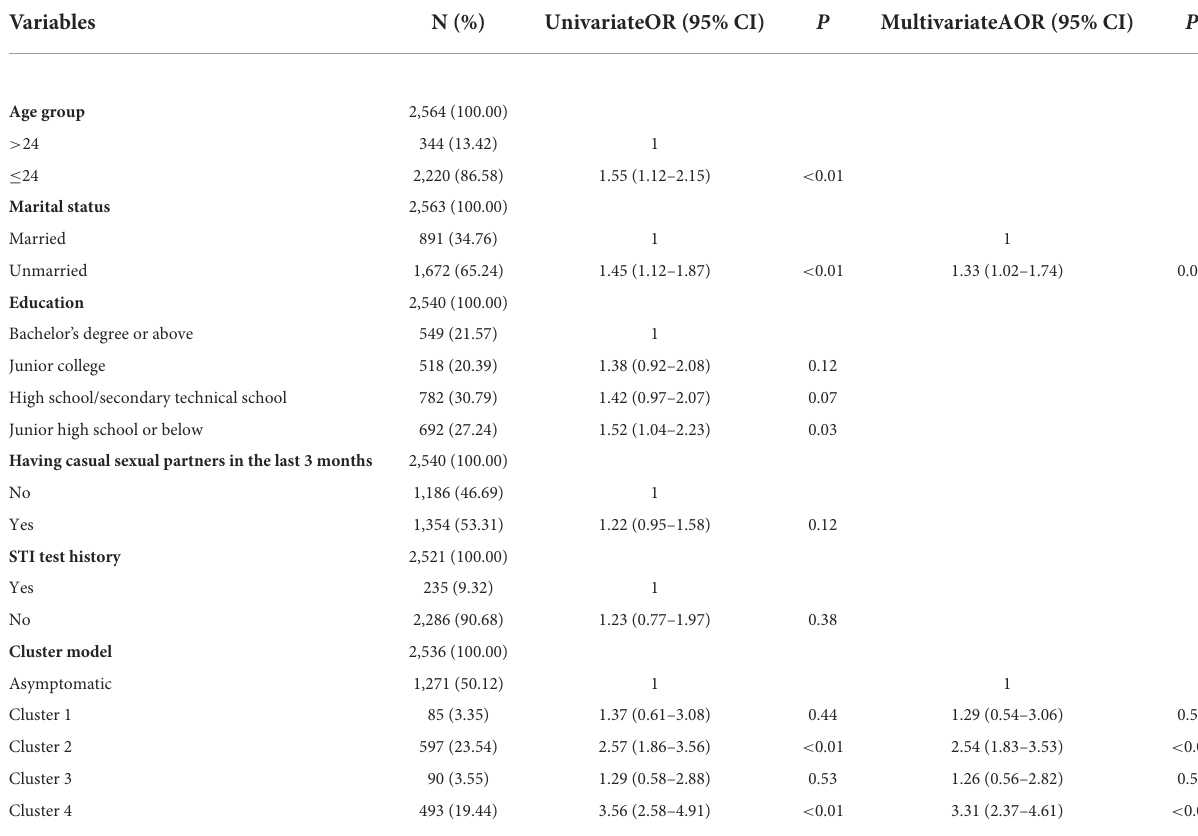
TABLE 3 Univariate and multivariate logistic regression analyses of factors associated with CT in men.